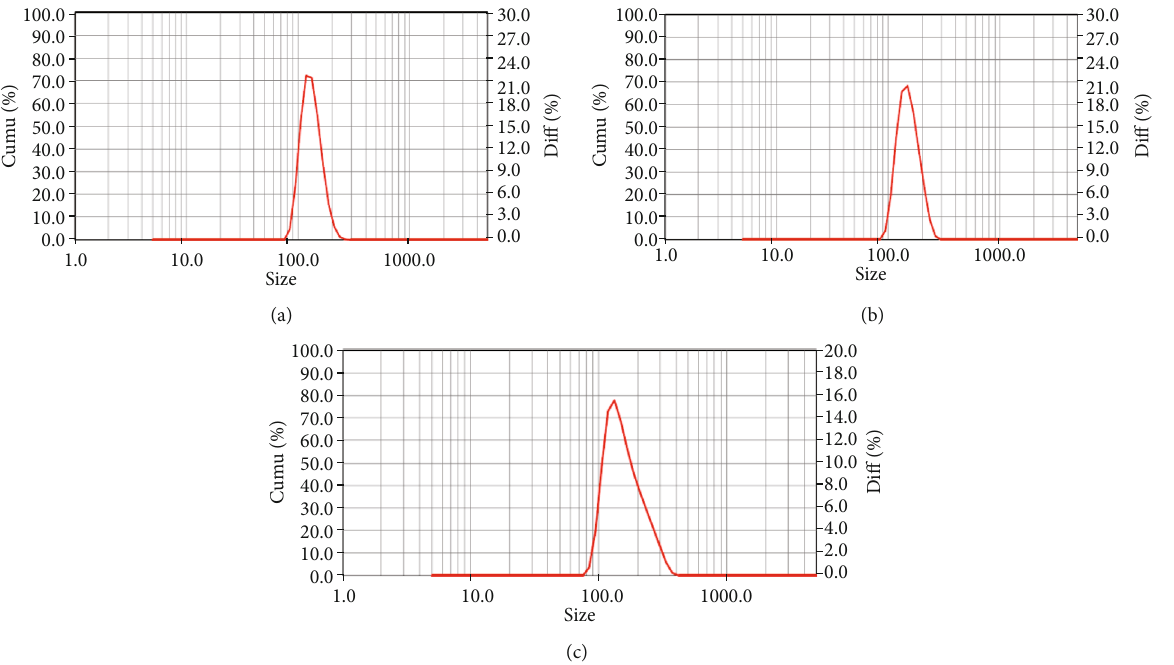
absorption band E4 (1685-1538 cm -1 ) belonged to a total GA-LDH was employed as a key skeleton of liposome, absorption constituted with the similar vibration frequency, and its characteristic absorption is presented in Figure 5(e), which consisted of unsaturated hydrocarbon vibration ν thus con fi rming GA-LDH as the main crystal phase in C=CH GA-LDH/LS. Lecithin was found as the key raw material (Figure 5(d), 1673 cm -1 ) of the cholesterol, ν bending O-H to form GA-LDH/LS, and its characteristic absorption peak vibration (Figure 5(b), 1635 cm -1 ) of water molecule between belonged to the stretching vibration of the ester carbonyl LDH interlayers, and the vibration stretching of benzene ring skeleton on the GA (Figures 5(a) and 5(b), 1633 cm -1 , 1595 cm -1 ). The absorption band E5 (700-400 cm -1 ) primar- tion of GA-LDH/LS; the scissor vibration δ (CH ily covered the stretching vibration ν (Figure 5(d), 1467 cm -1 ) on the hydrophobic chain was (Figure 5(b), M-OM, MO 448 cm -1 , M =Mg, Al) of lattice oxygen in GA-LDH. found at the 1466 cm -1 position of GA-LDH/LS. The